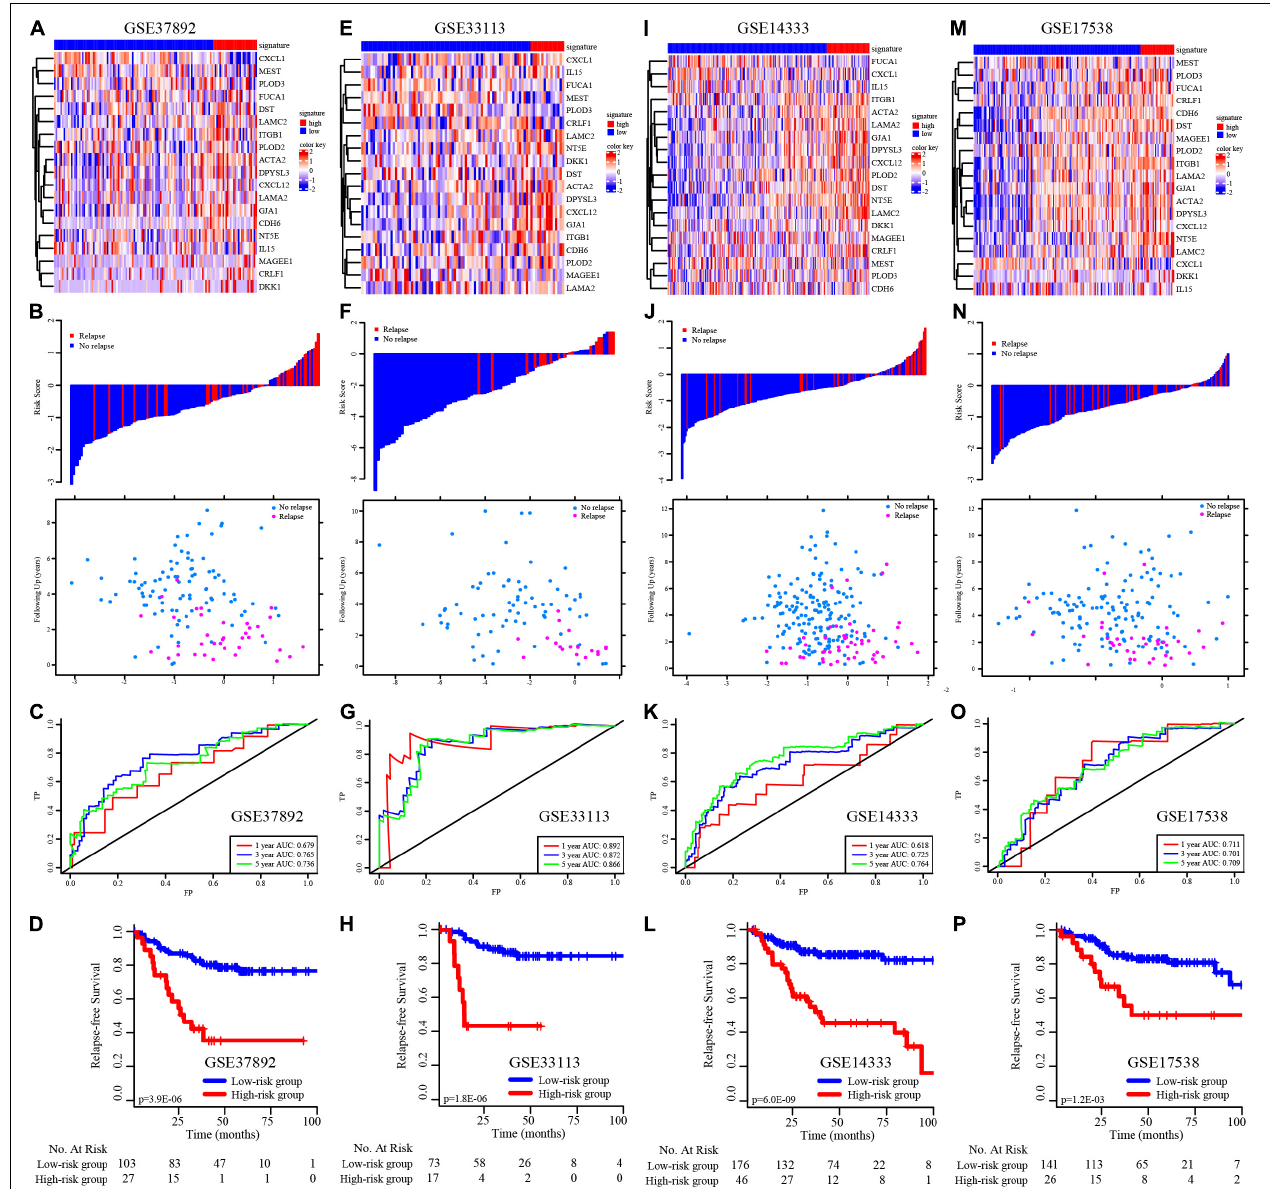
FIGURE 3 | K–M survival analysis, risk score assessment by the EMT-related gene signature and time-dependent ROC curves in the external independent validation data sets. (A–D) The heatmap, distribution of relapse time and status related to risk scores, K–M survival analysis of high − and low-risk groups, and time-dependent ROC curve for RFS in GSE37892 set. (E–H) The heatmap, distribution of relapse time and status related to risk scores, K–M survival analysis of high − and low-risk groups, and time-dependent ROC curve for RFS in GSE33113 set. (I–L) The heatmap, distribution of relapse time and status related to risk scores, K–M survival analysis of high − and low-risk groups, and time-dependent ROC curve for RFS in GSE14333 set. (M–P) The heatmap, distribution of relapse time and status related to risk scores, K–M survival analysis of high − and low-risk groups, and time-dependent ROC curve for RFS in GSE17538